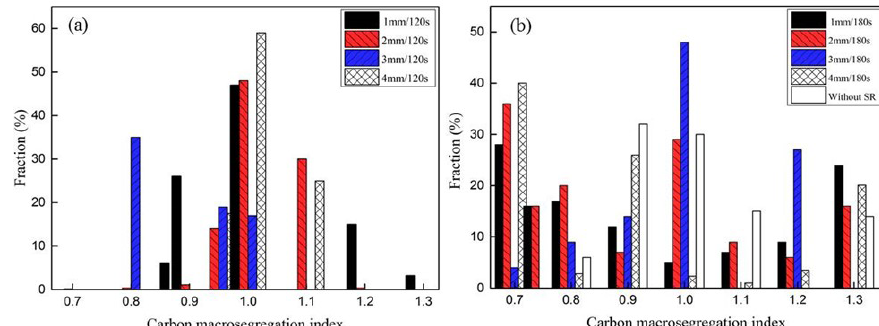
Figure 8. The fraction of different carbon macrosegregation indexes in the middle of the ingot (a) at 120s, (b) at 180s.